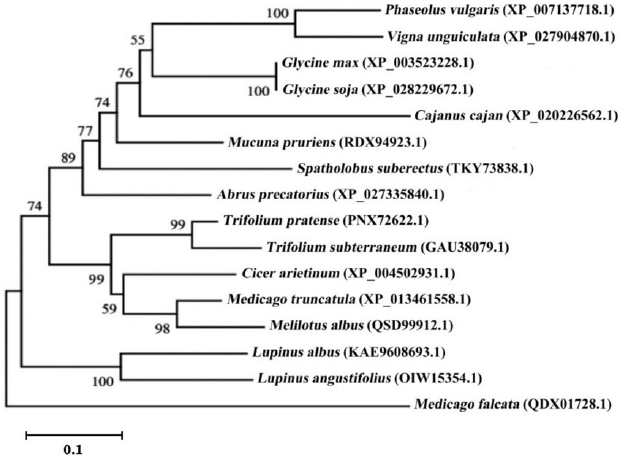
Figure 3. The phylogenetic tree based on the amino acid sequences of a total of 15 NAC proteins and GmNAC3 protein using the neighbor-joining method of MEGA11. GenBank accessions are given in the parentheses after the species names. Bootstrap values based on 1000 replicates are given next to the branches.